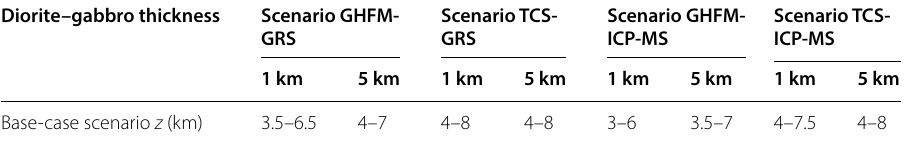
Table 7 Drilling depth to reach the temperature interval 50–100 °C Diorite–gabbro